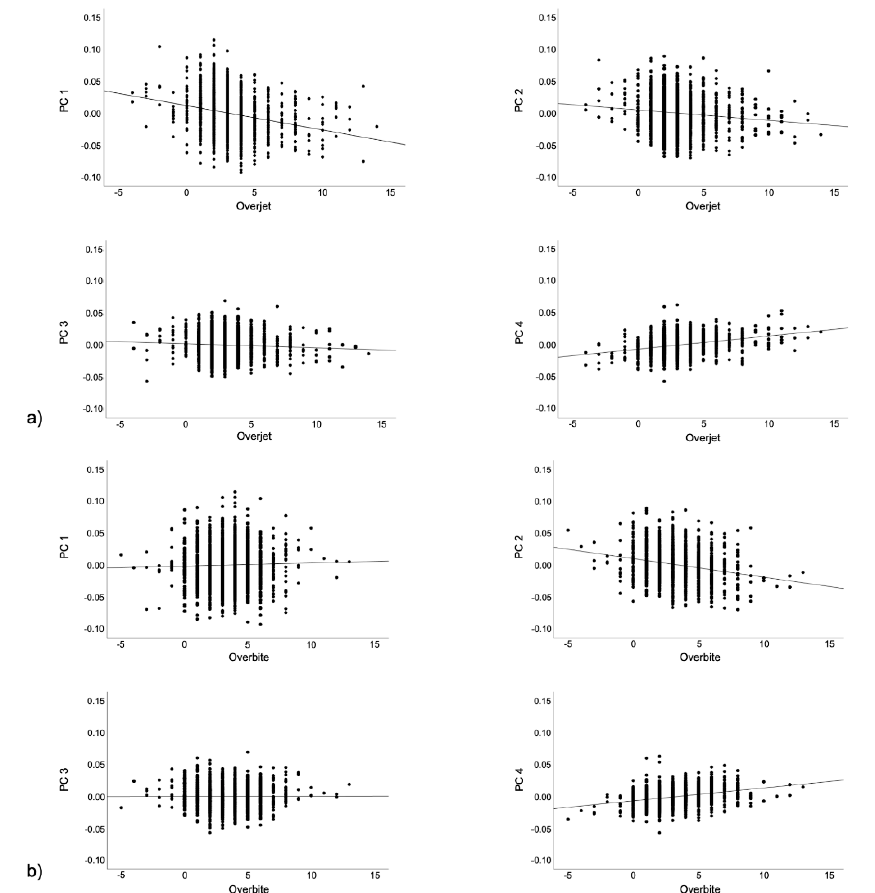
Figure 2. Association between overjet ( a ) and overbite ( b ) and the first primary PCs, explaining of the sample >70% of the sample variability.